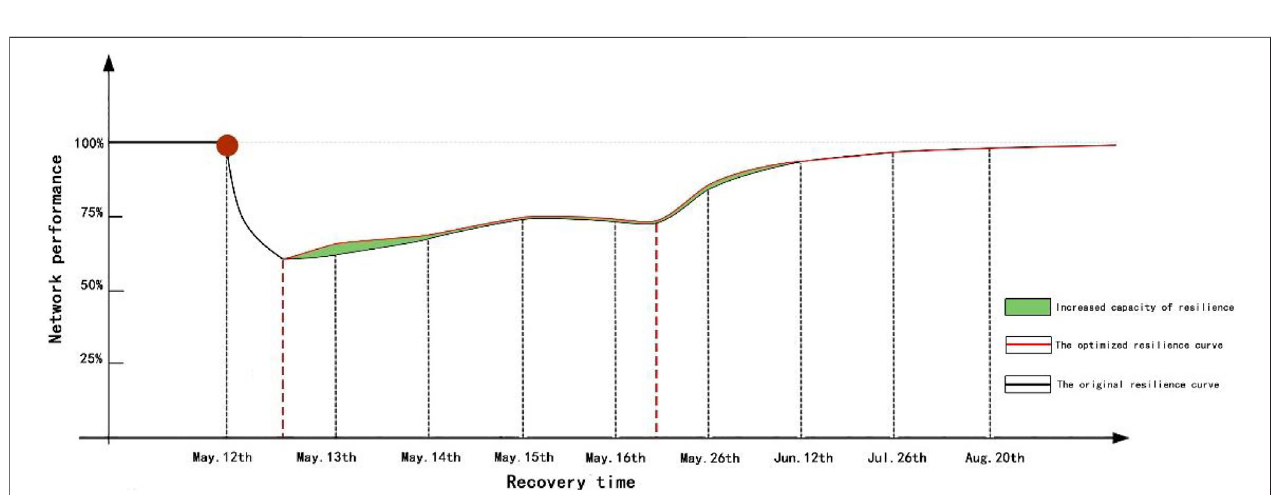
FIGURE 16 | Optimization of road resilience in the study target